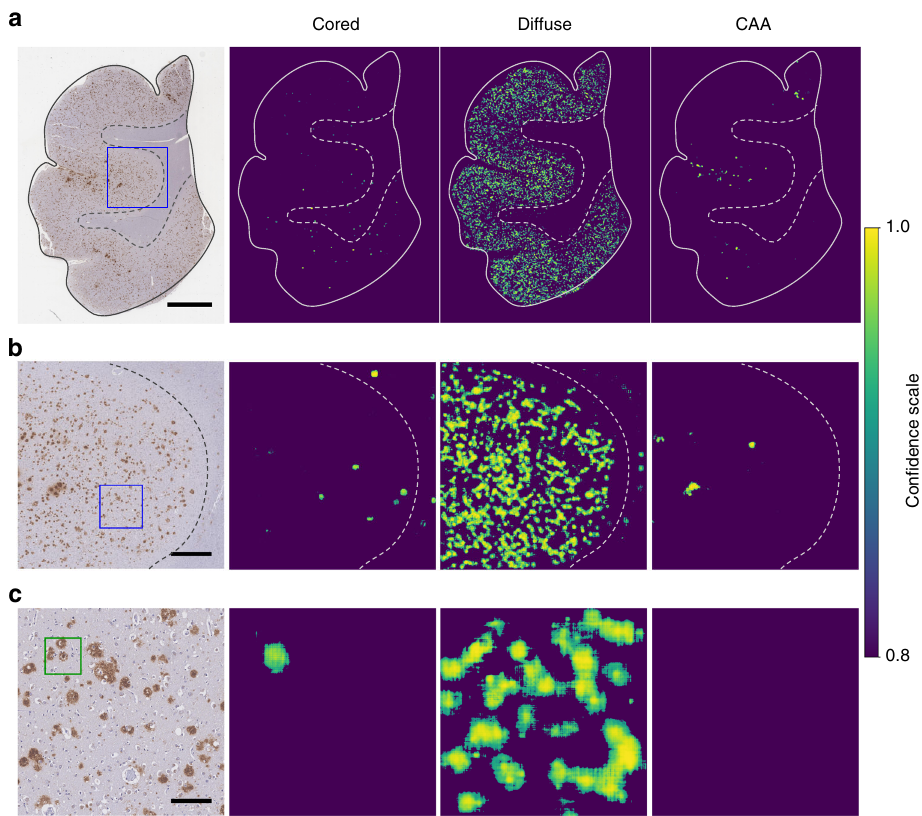
Fig. 5 Prediction con fi dence heatmaps for cored plaques, diffuse plaques, and CAA. a Whole slide overview visualization, revealing broad amyloid distribution patterns. Scale bar = 3 mm. b Higher magni fi cation (×4) view of the blue-boxed region from panel a . Scale bar = 750 μ m. c Higher magni fi cation (×20) view of the blue-boxed region from panel b . Green box marks cored plaque manual annotation. Scale bar = 150 μ m. Con fi dence scales for each panel were bottom-capped to aid visualization, such that only con fi dence scores ≥ 0.8 are plotted, with yellow being the most con fi dence, and purple the least. Approximate (hand-drawn) boundaries of gray versus white matter (dotted line) and tissue boundaries (solid lines) are overlaid for